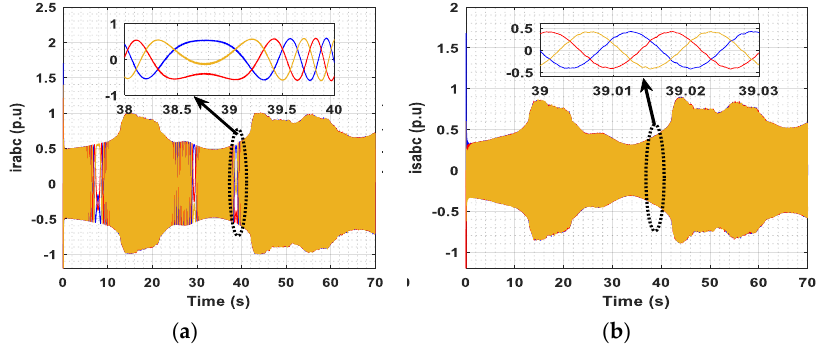
Figure 12. ( a ) Rotor current, ( b ) stator current waveforms under PIC.